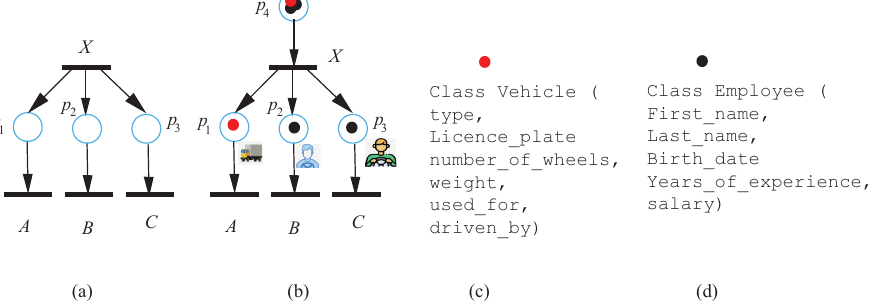
Figure 4. ( a ) Modeling Scenario 4, ( b ) the effects after predecessor X fires, ( c , d ) pseudo-code for the declaration of two different